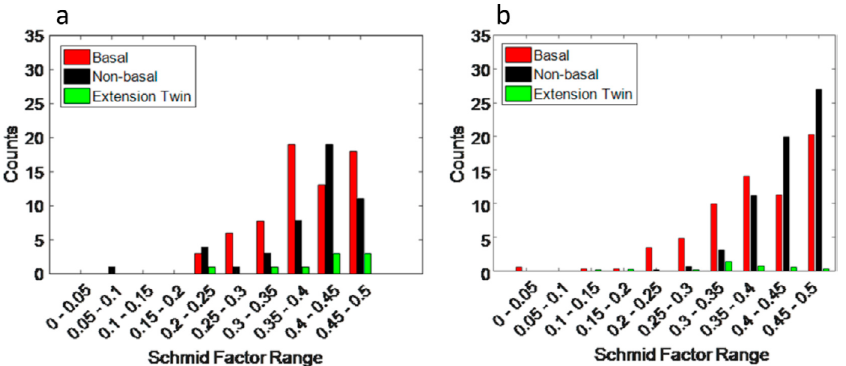
Figure 19. Comparison of active deformation modes versus corresponding Schmid factor at a uniaxial tensile strain of ε = 4.86% ( a ) SEM-DIC experimental data, ( b ) CPFE simulation results (After Githens et al.